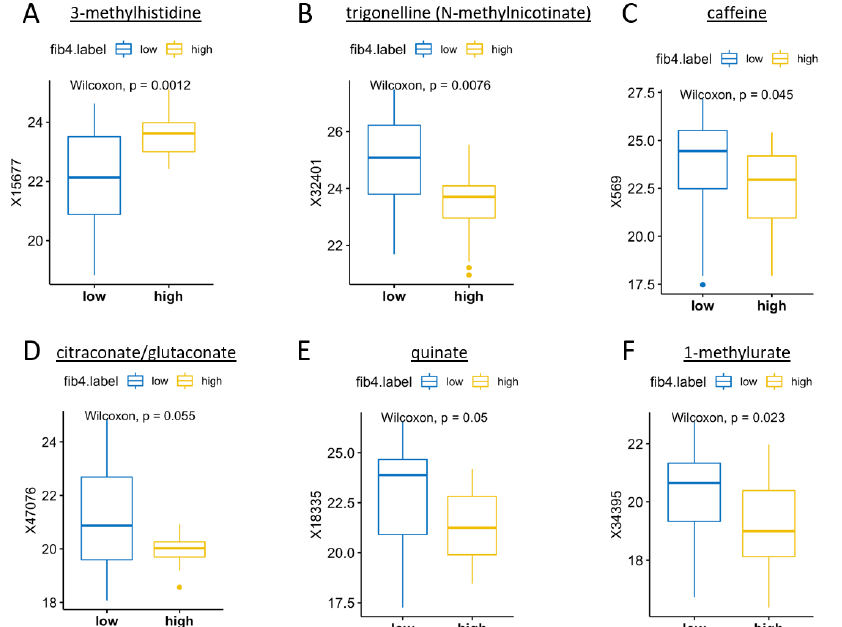
Figure 2. The most differentially expressed metabolites in participants with and without FIB-4 ≥ 1.45. Figure1. Figure1.